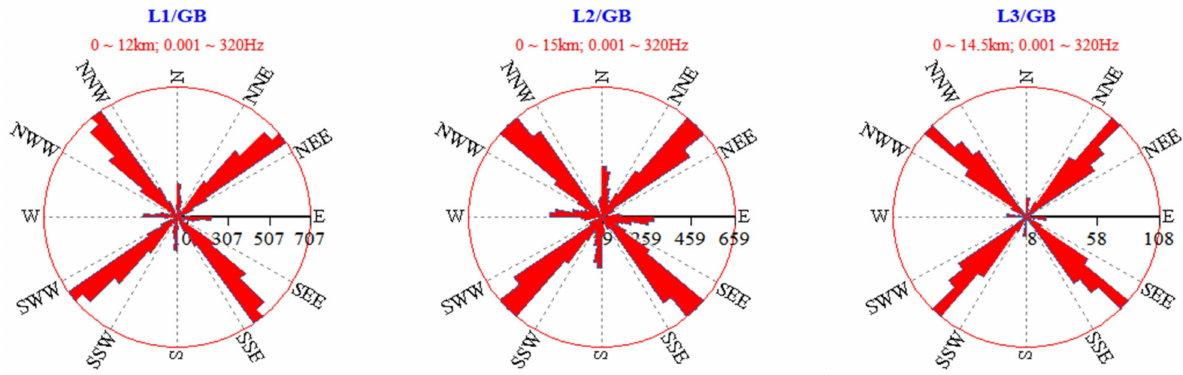
Figure 8. Rose histogram of the results of the electrical principal axis analysis of the L1-3 profile. ( left ) L1 profile, ( middle ) L2 profile, and ( right ) L3